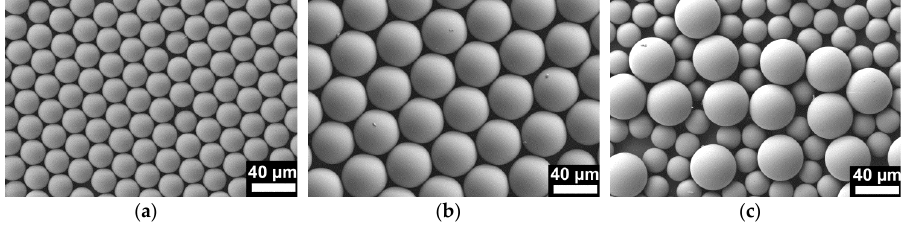
Figure 1. Scanning electron microscopy images of monolayers of PS microspheres spin-coated on Si wafers, which were used as primary molds to prepare PDMS secondary molds. ( a ) r s = 12.5 µm; ( b ) r s = 22.5 µm; ( c ) r s = 12.5 and r s = 22.5 µm.